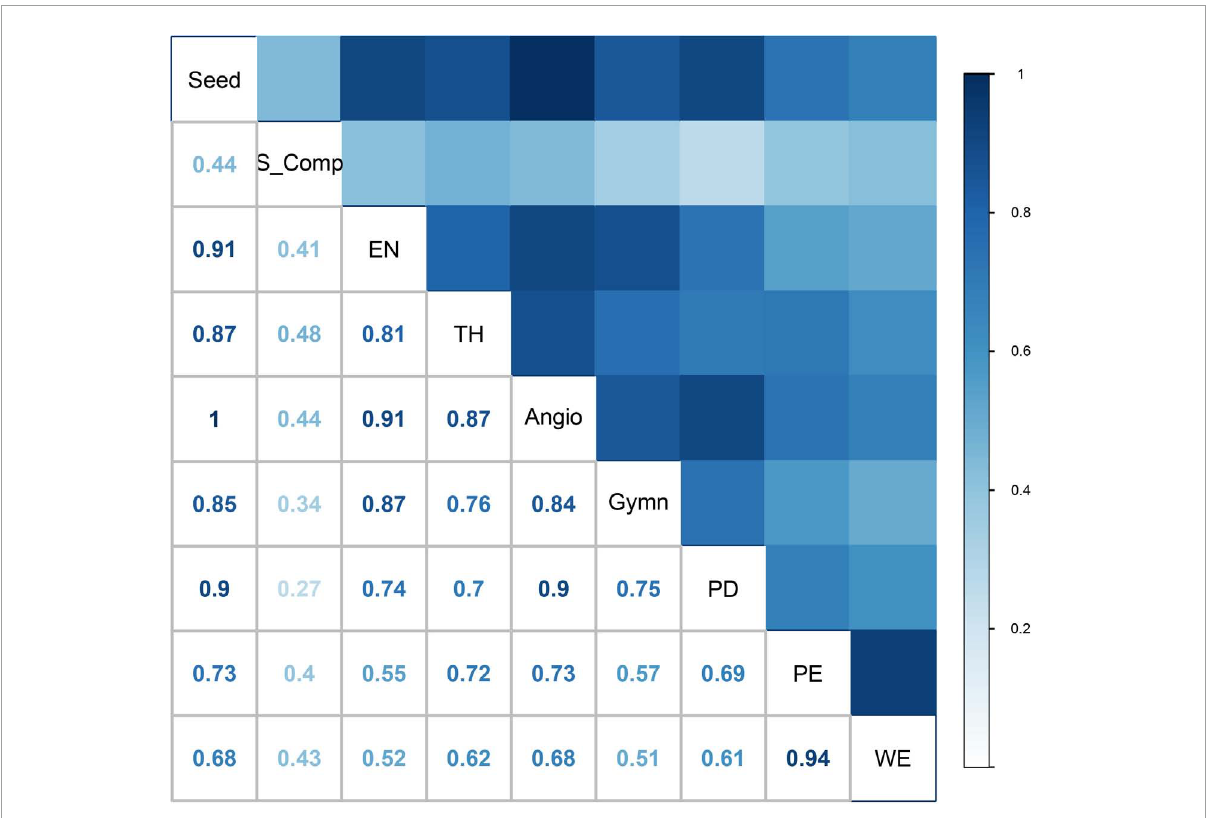
FIGURE3 Correlation between species distribution patterns and spatial phylogenetics: all the seed plant species (Seed), angiosperms (Angio), gymnosperms (Gymn), endemic species (EN), and threatened species (TH) according to the species richness algorithm; all the species (S_Comp) according to the complementary algorithm; phylogenetic diversity (PD), phylogenetic endemism (PE), and weighted endemism (WE) according to spatial